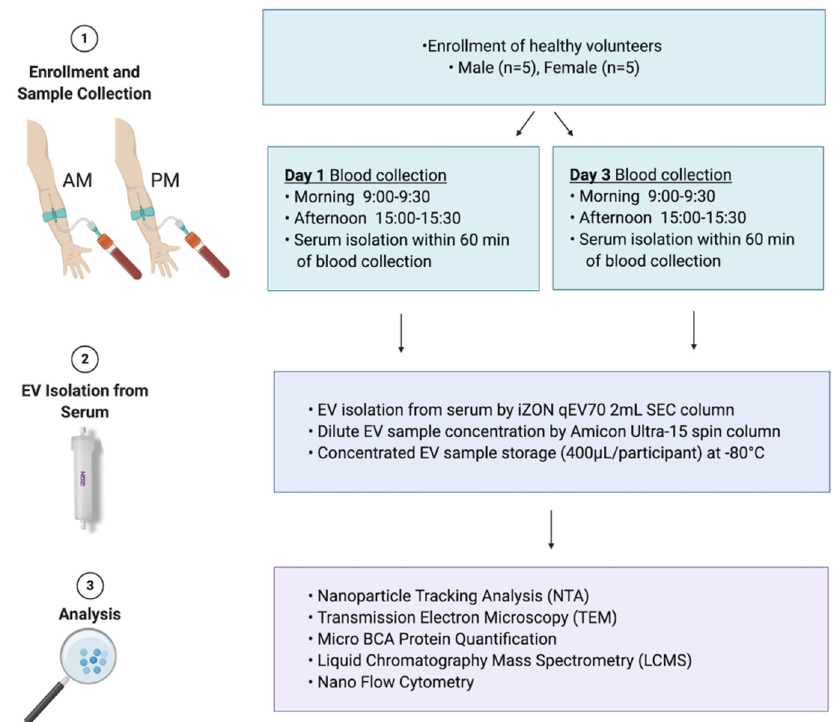
Figure 1. Study design. A cohort of healthy males and females aged 18 to 65 years were recruited ( n = 10) for extracellular vesicle variability study (EVV). Blood was collected in the morning (AM) and the afternoon (PM) on day 1 and day 3 of the study. Participants were fed on day 1 and fasted on day 3 for morning blood collection. Serum was isolated from whole blood and used for extracellular vesicles (EV) isolation. EVs were isolated using qEV70 2 mL SEC column, concentrated to the volume of 400 µ L in phosphate buffered saline (PBS) and used for downstream analyses. These included nanoparticle tracking analysis (NTA) to determine EV concentration/yield, transmission electron microscopy (TEM) for EV size estimations and morphology assessment, microBCA protein quantification, liquid chromatography mass spectrometry (LCMS) for EV protein quantification, and nano flow cytometry for EV surface marker characterisation (EV-TRACK ID: